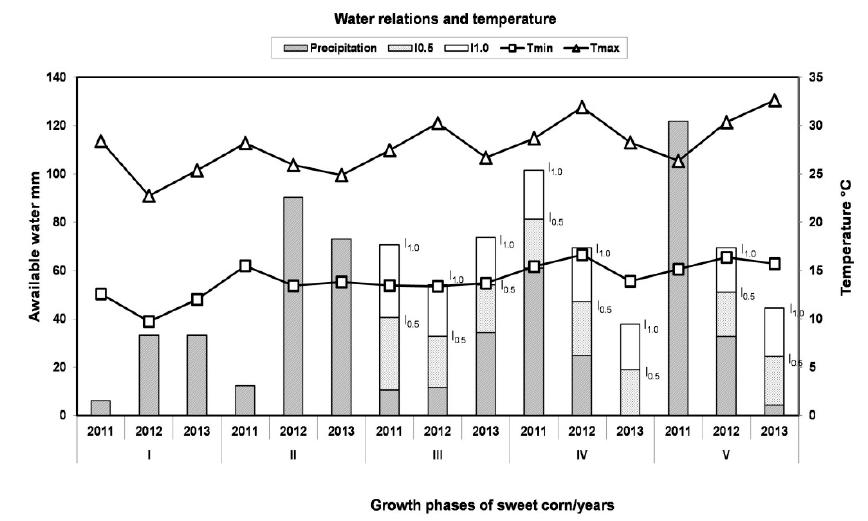
Figure 1. Water relations and temperature during the growth of sweet corn; I = from sowing to emergence, II = from emergence to 6–8 leaf stage, III = tasseling, IV = silking, V = from silking to harvesting.